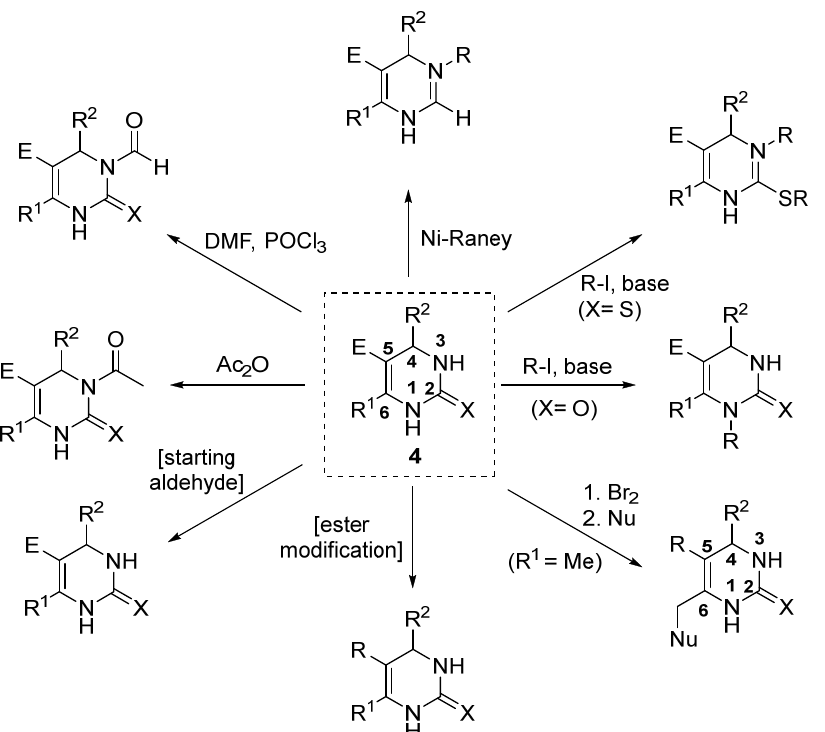
Scheme 91. Scaffold decoration of